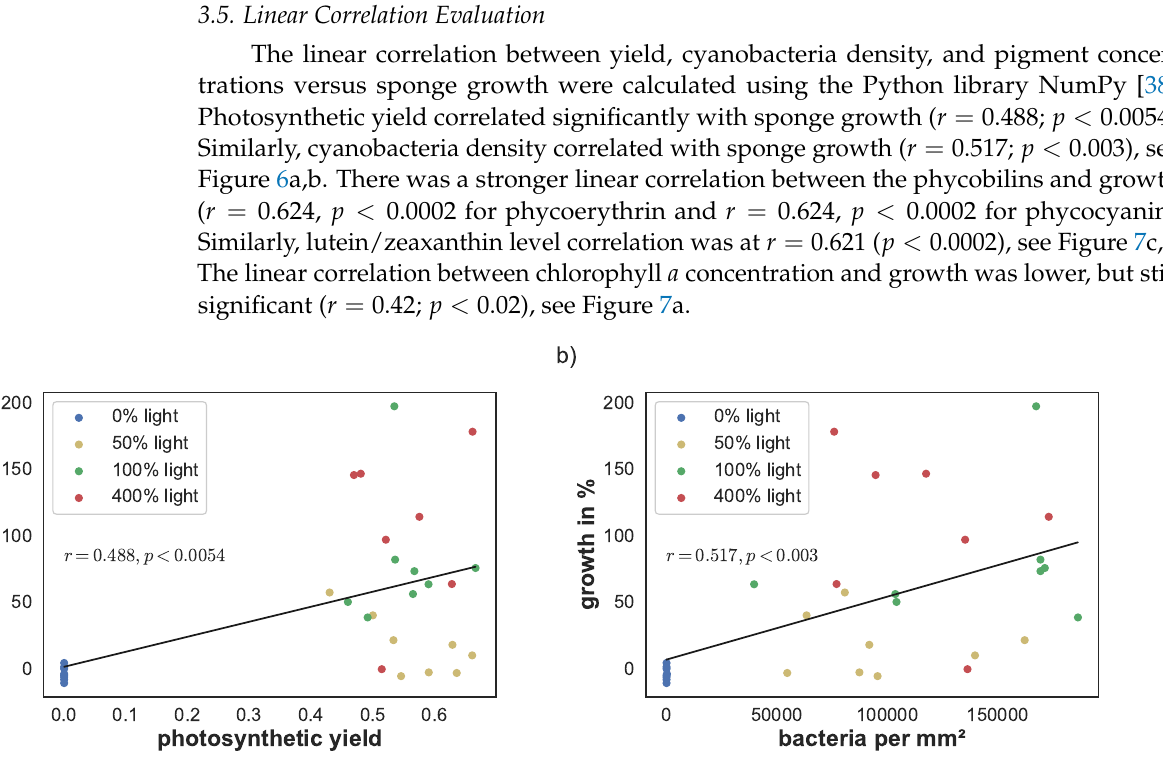
Figure 5. Exemplary photos of the sponge’s appearances in the different light conditions after 68 days. ( a ) darkened, ( b ) 50% light, ( c ) 100% light, ( d ) 400% light. Fluorescence Microscopy images show the density of autofluorescent cyanobacteria ( e ) darkened, ( f ) 50% light, ( g ) 100% light, ( h ) 400% light. Scale bars 10mm ( a – d ) and 20µm ( a – d ).